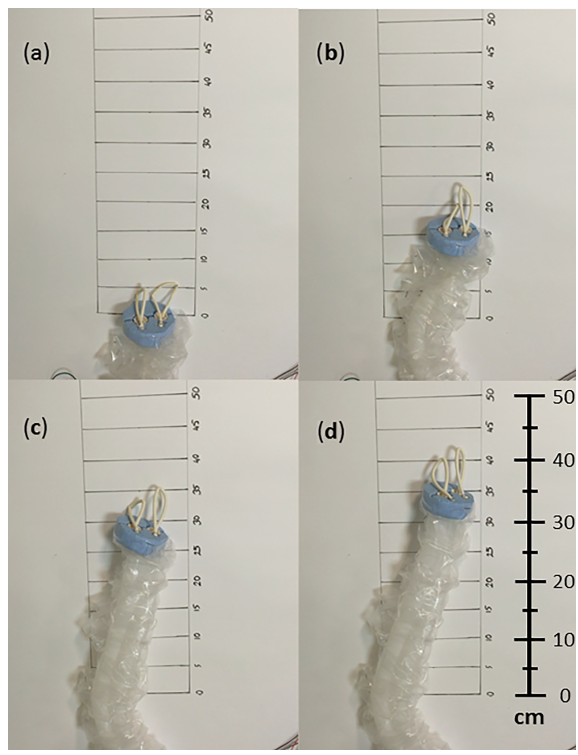
Figure 11. Robot elongating by inflating both balloons at the same time. Numbers are in